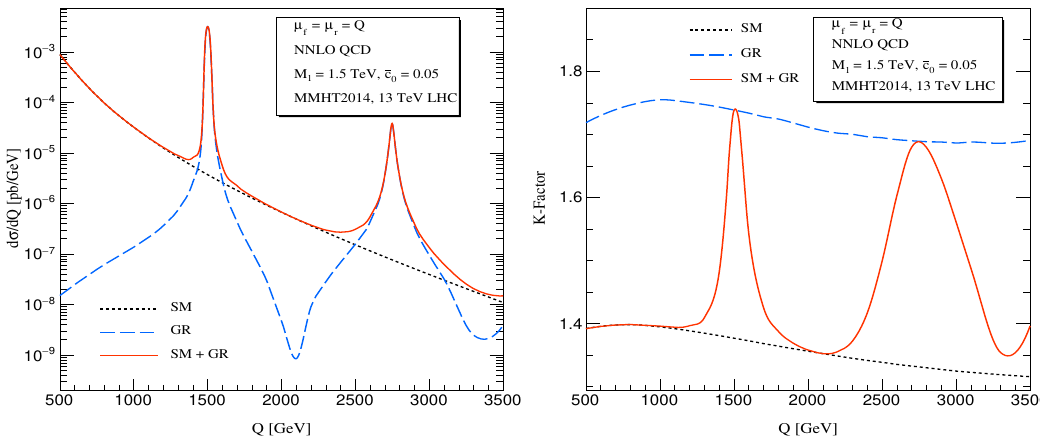
Figure 4 . Invariant mass distribution of di-lepton for the SM, RS model and for the signal (left) and their corresponding K-factors (right).